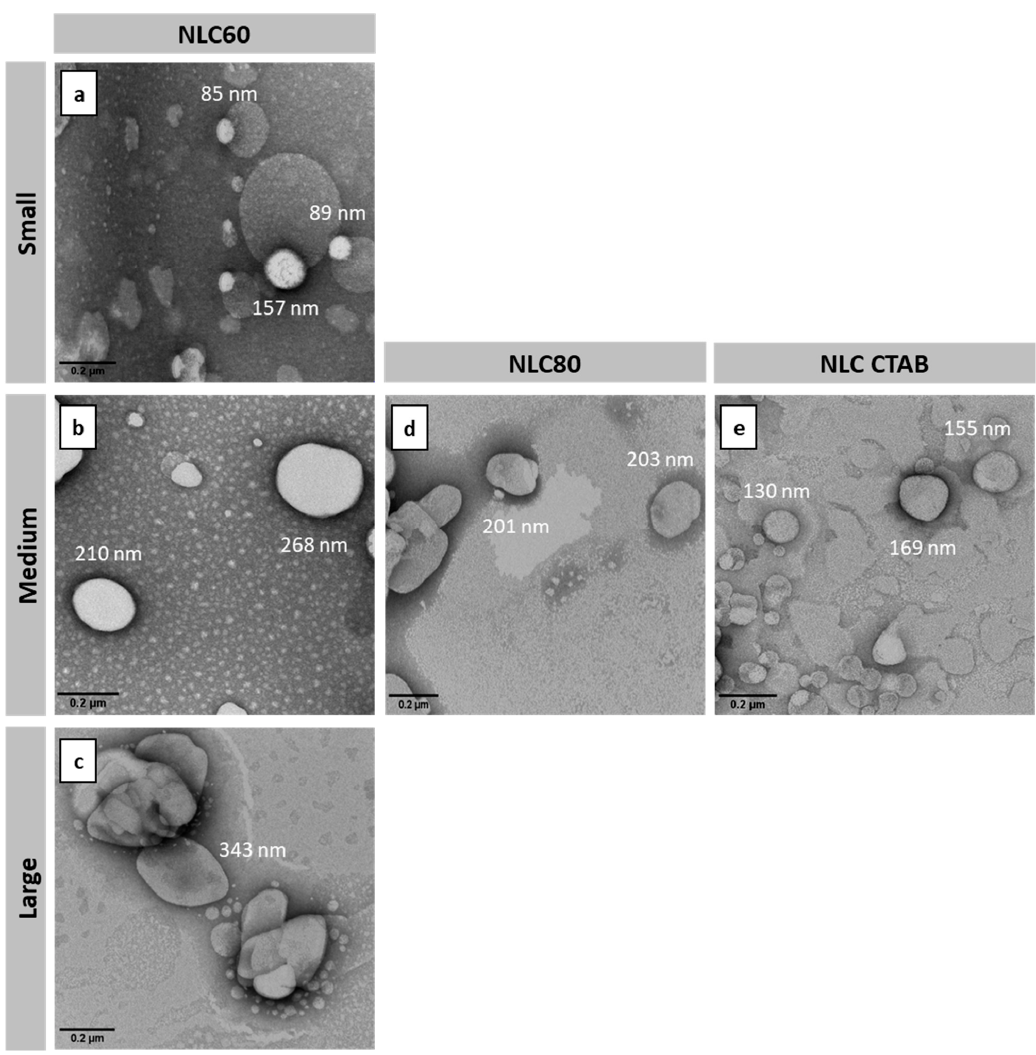
Figure 3. Transmission electron microscopy (TEM) micrographs of the different NLCs. ( a ) NLC60 S , ( b ) NLC60 M , ( c ) NLC60 L , ( d ) NLC80 and ( e ) NLC CTAB. Nanoparticle diameter was measured in triplicate, final size value corresponds to the mean of the measurements. Magnification: 53.000×. Scale bars = 0.2 µm.